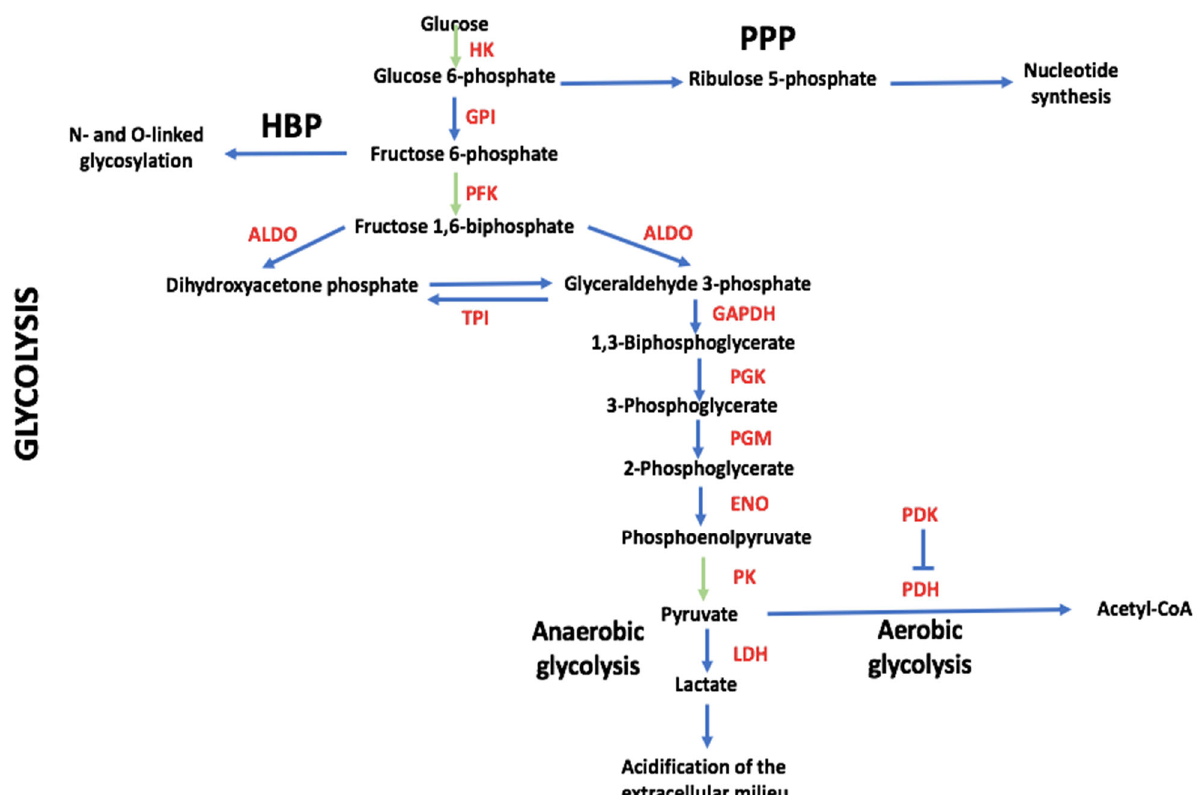
Figure 1. Glycolytic Metabolism. Enzymes and metabolites are depicted as well as some of the pathways that branch off from glycolysis and are discussed in the text. Green arrows indicate irreversible reactions. The final steps occurring under aerobic (aerobic glycolysis) or anaerobic conditions (anaerobic glycolysis) are indicated. ALDO, fructose-biphosphate aldolase; ENO, enolase; GAPDH, glyceraldehyde 3-phosphate dehydrogenase; GPI, glucose 6-phosphate isomerase; HBP, hexosamine biosynthetic pathway; HK, hexokinase; LDH, lactate dehydrogenase; PDH, pyruvate dehydrogenase; PDK, pyruvate dehydrogenase kinase; PFK, phosphofructo-2-kinase; PGK, phosphoglycerate kinase; PGM, phosphoglycerate mutase; PK, pyruvate kinase; PPP, pentose phosphate pathway; TPI, triosephosphate isomerase.